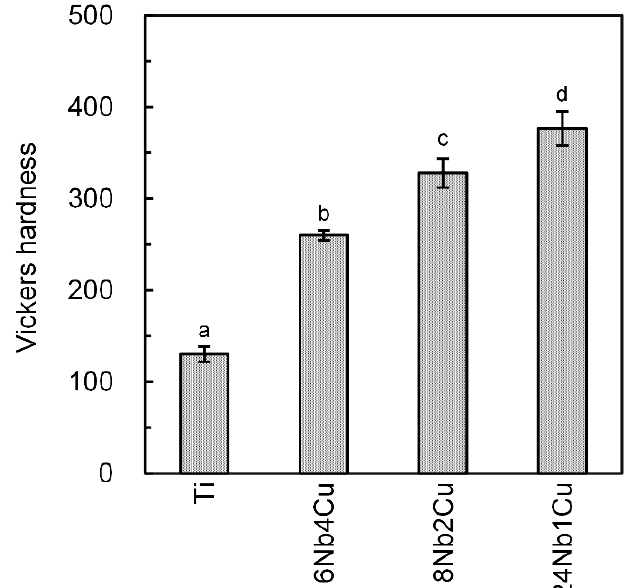
Figure 2. Vickers hardness values for Ti − Nb − Cu alloys. Different roman letters indicate a statistically significant difference ( p < 0.05).